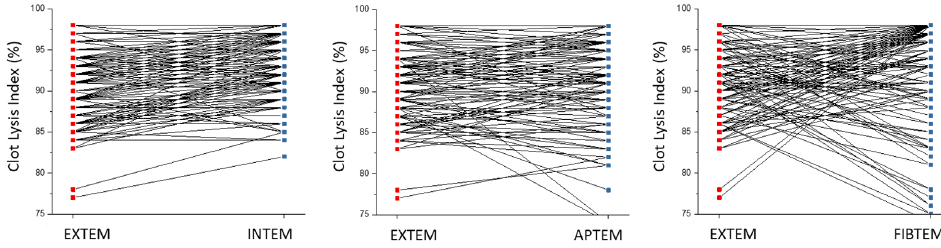
Figure 2. Pair plots showing the similarity between clot lysis index values obtained with EXTEM, INTEM, and APTEM. In contrast, inhibition of clot retraction with FIBTEM increased the clot lysis index in many cases.